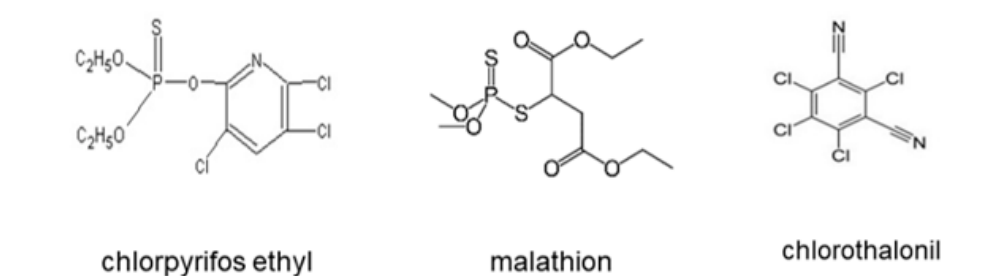
Figure 1. Structure of studied pesticides. Table 1. Classification and characteristics * of agrochemicals used in the prickly pear pad study.